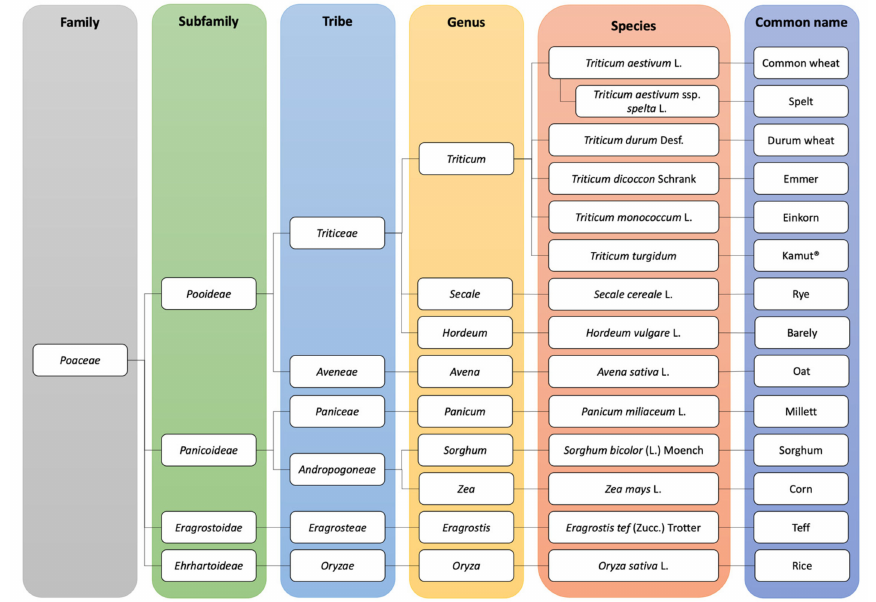
Figure 1. Botanical classification of cereals